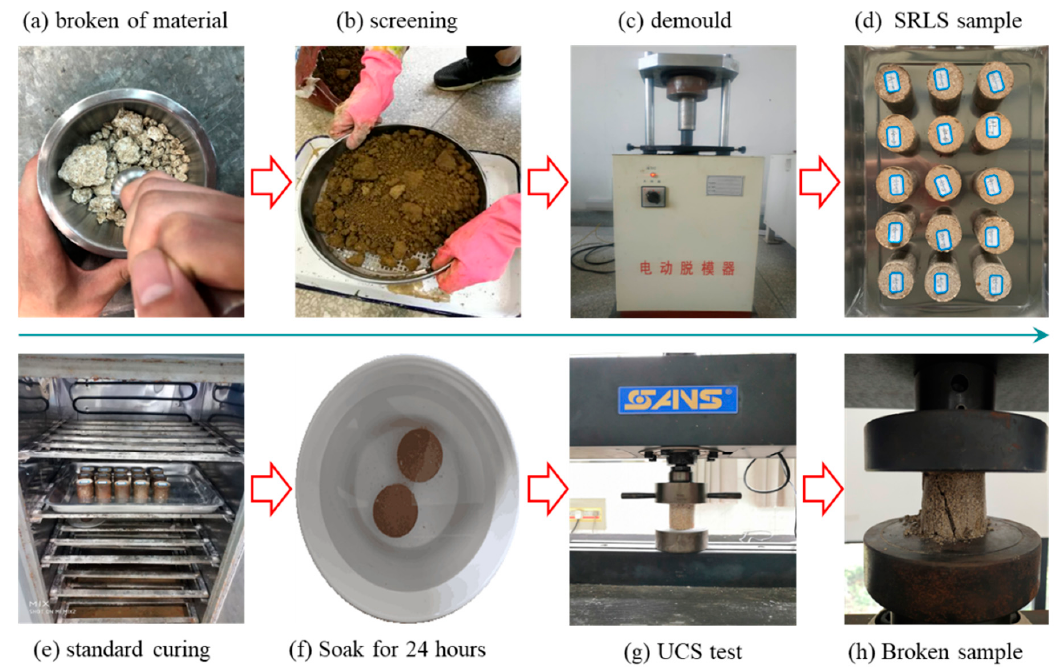
Figure 6. Specimen preparation and test processes.